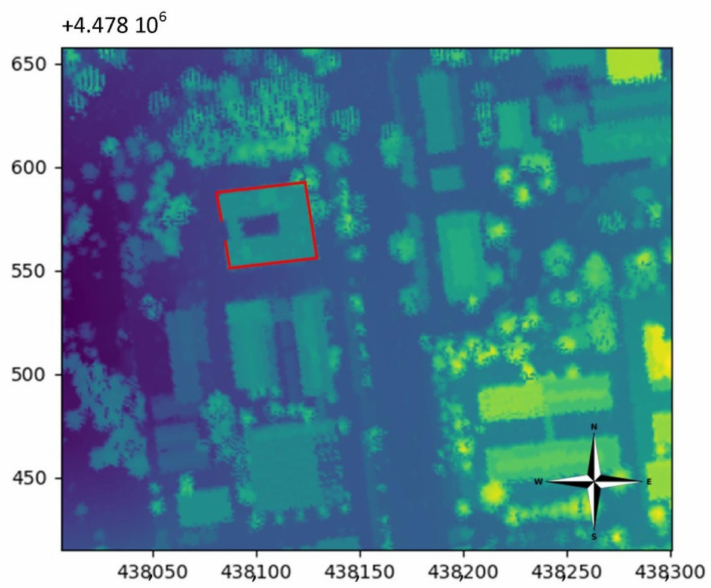
Figure 2. Digital Surface Model (DSM) of the CIEMAT area with the contour of the building under study marked in